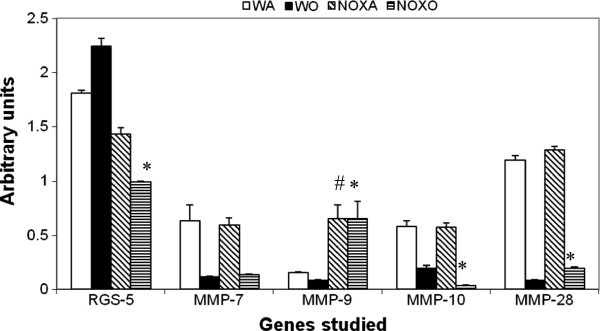
Downregulation Rho kinase RGS-5 and MMP10 but upregulation of MMP9 and MMP28 genes in KO lung. Real time PCR analysis was used to quantitate expression of mRNA for the particular genes as calculated by relative index of Ct values normalized to GAPDH by real time PCR. PCR was carried out using the comparative Ct method (Applied Biosystems software) with SYBR Green PCRcore reagents (Applied Biosystems) and anlysed using Applied Biosystems 7900HT Real-Time PCR System software SDS 2.2.1. All primers used were specific to mouse. * denotes p value<0.01 compared to WT+OVA values. # denotes p value<0.01 compared to WT+alum (control baseline values). n=5/group pooled from 2 experiments. Expression of the gene of interest was expressed in relative values normalized to the values obtained for mouse GAPDH. Compared to post-OVA WT values, Rho kinase RGS-5 mRNA was decreased 2.3-folds and MMp-10 3-fold, while MMP-9 was increased 8-fold and MMP-28 increased 2.3-fold (*denotes p value<0.05 compared to post-OVA WT).